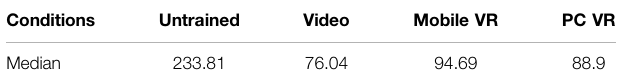
TABLE 4 | The completion times of the untrained and trained subjects in the immediate